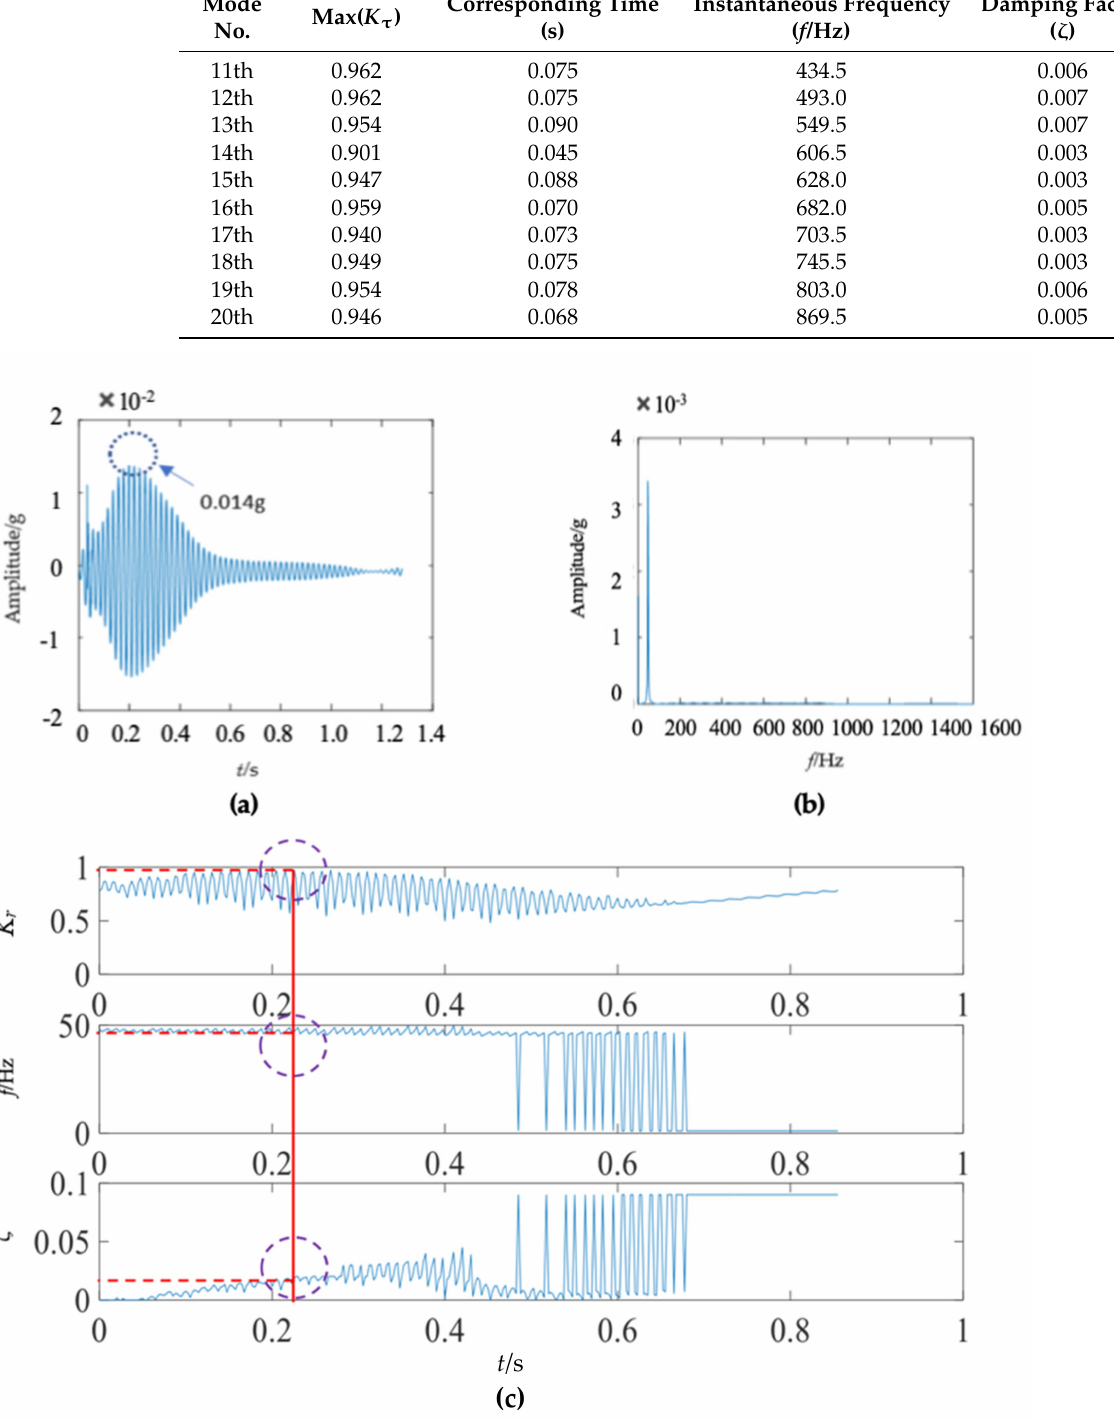
Figure 8. Second mode in the vibration response signal of the wooden utility pole labeled as 57704: ( a ) the vibration response of the second mode in the time domain, ( b ) the frequency spectrum of the second mode, and ( c ) the results of Laplace wavelet correlation filtering of the second